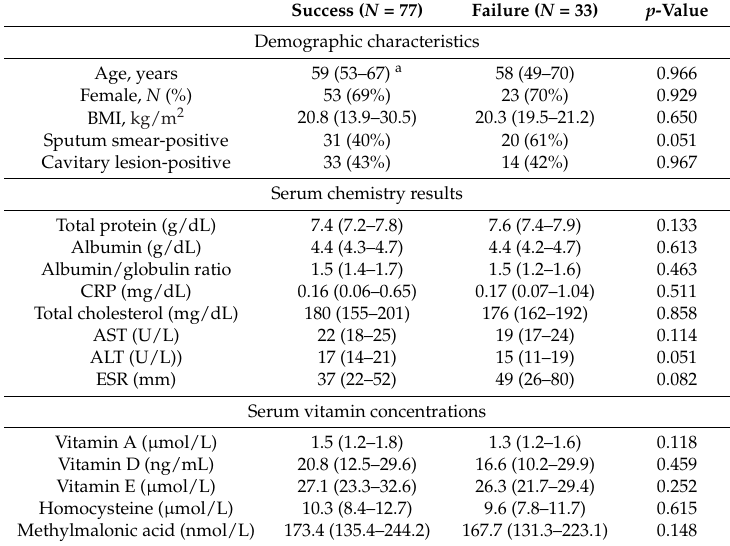
Table 4. Serum vitamin status and treatment outcomes in patients with NTM-PD. Success ( N = 77) Failure ( N = 33) p